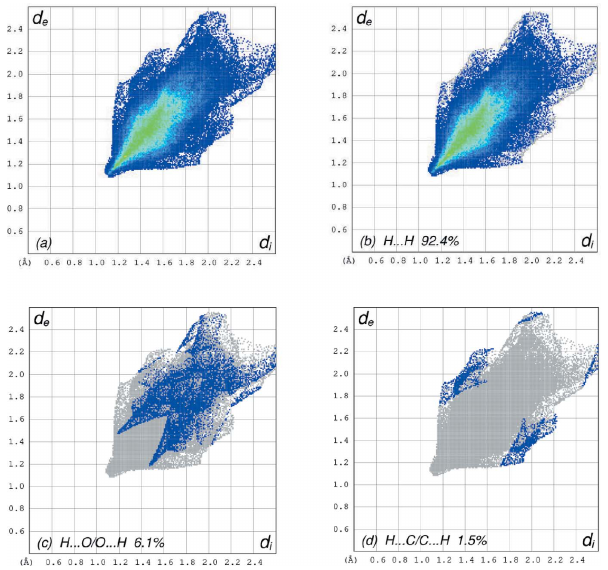
Figure 4 The full two-dimensional fingerprint plots for the title compound, showing ( a ) all interactions, and those delineated into ( b ) H (cid:2)(cid:2)(cid:2) H, ( c ) H (cid:2)(cid:2)(cid:2) O/O (cid:2)(cid:2)(cid:2) H and ( d ) H (cid:2)(cid:2)(cid:2) C/C (cid:2)(cid:2)(cid:2) H interactions. The d i and d e values are the closest internal and external distances (in A˚ ) from given points on the Hirshfeld surface contacts.